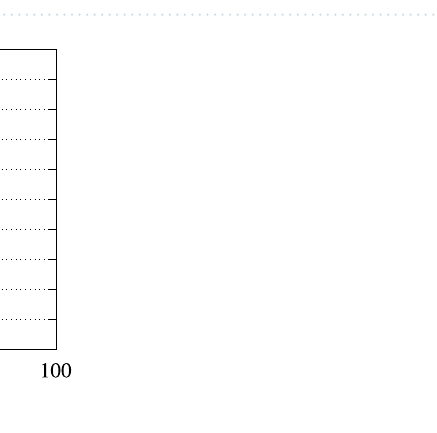
Figure 6. The sensor sheet is mounted between the two aluminum blocks and placed inside a thermal chamber. Subsequent temperatures are reached and the sensor sheet is read at each point.